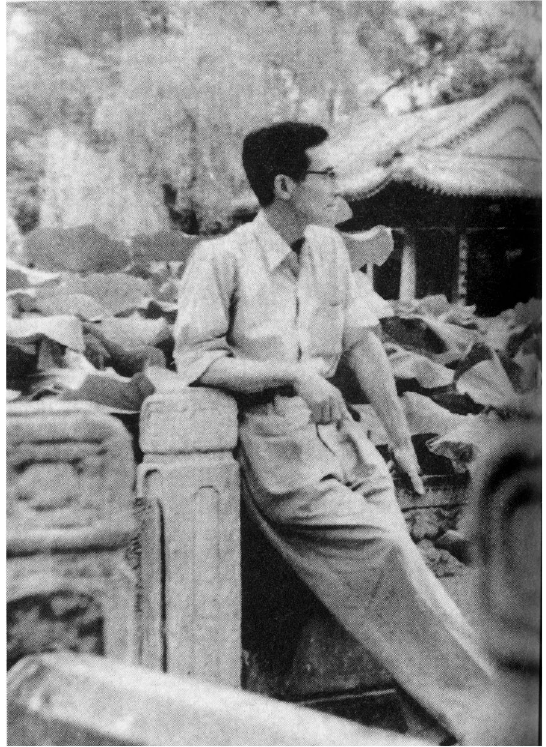
Fig. 5 Photo showing Liang Sicheng in relaxed posture in the Summer Palace in 1955 (Source: Lin 2011,